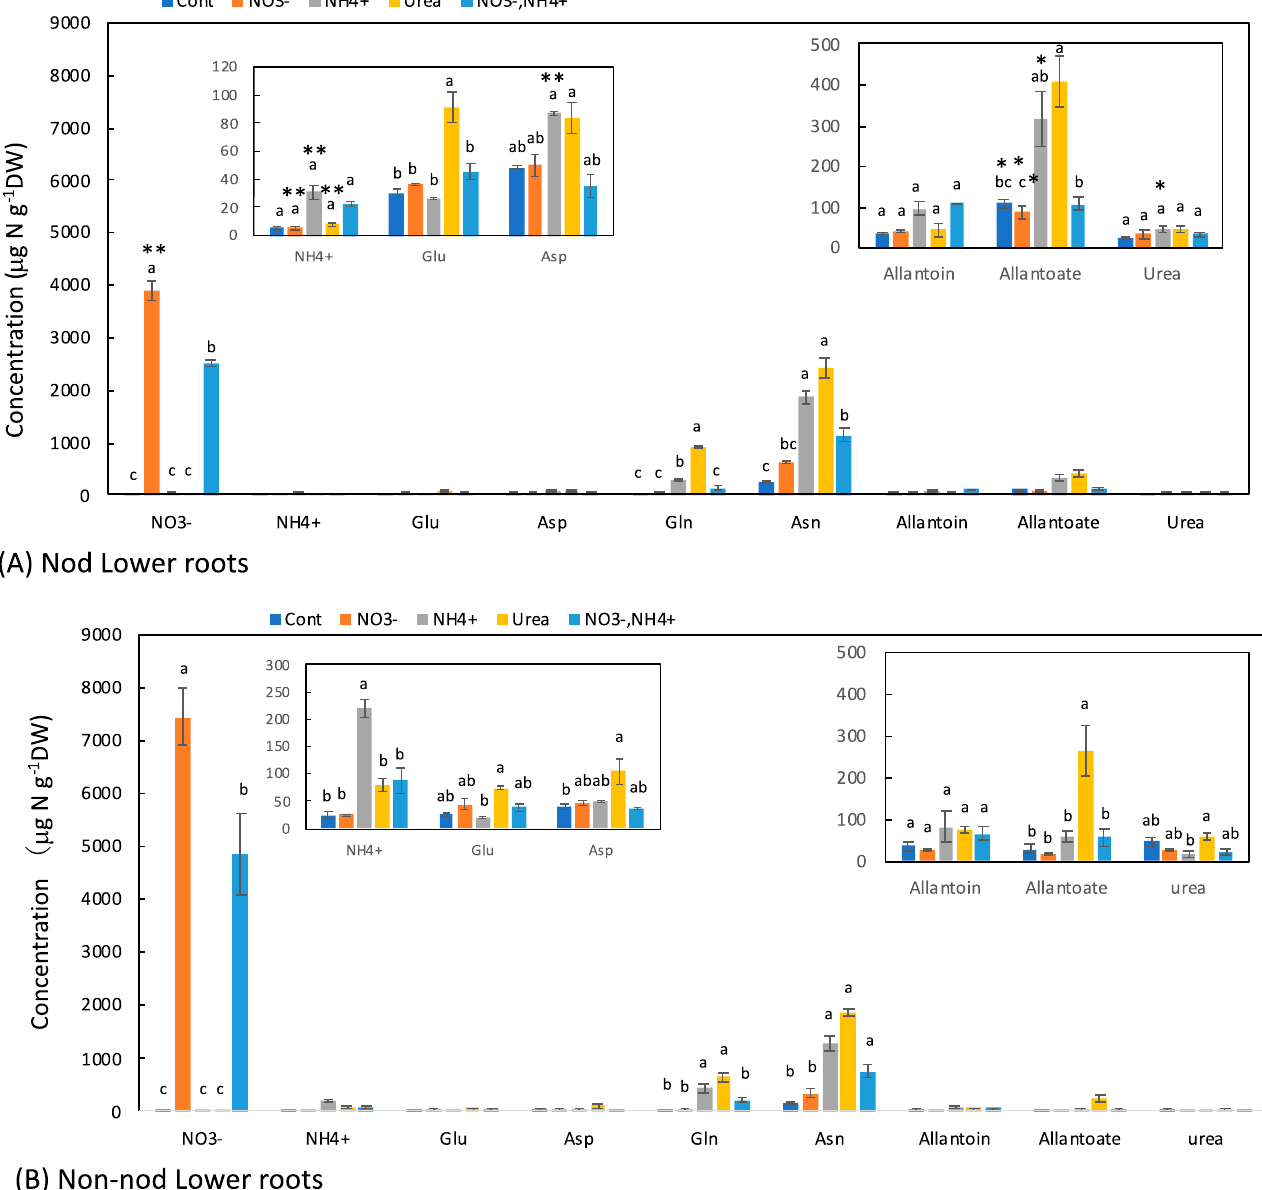
Figure 4. Comparison of the concentrations of the principal N metabolites in the lower roots of the Nod and Non-nod soybean plants treated with various N compounds. The symbols, abbreviations and the explanations of the statistics are the same as in Figure 2.